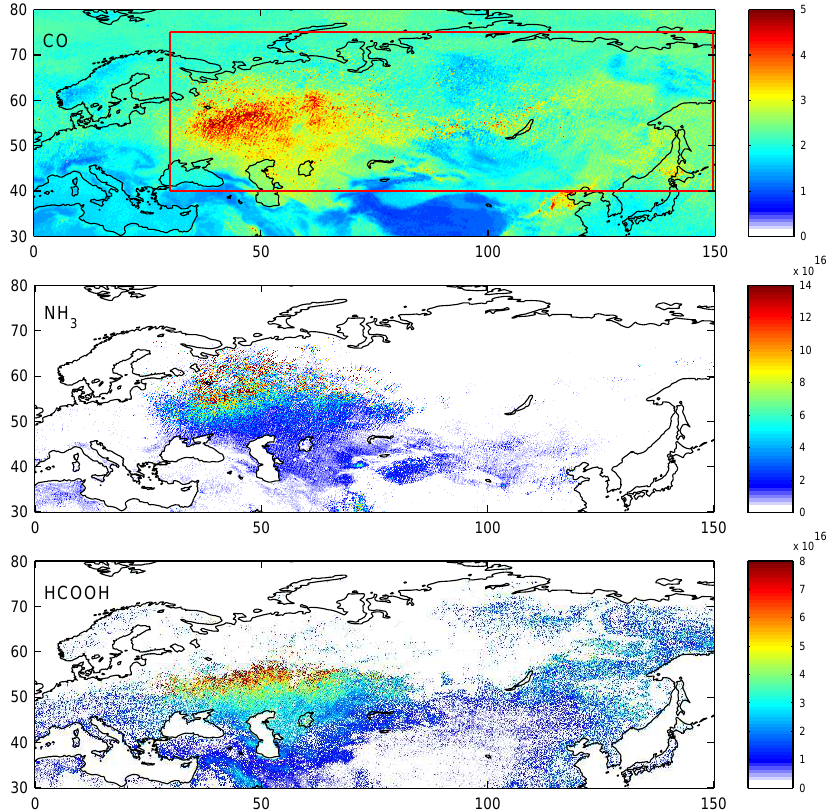
Fig. 1. IASI morning observations of the 2010 Russian wildfires plumes. The 3 panels show the mean CO, NH 3 and HCOOH total columns Fig.1. IASImorning observations ofthe2010 Russianwildfiresplumes. The3panelsshow themean CO , NH 3 and HCOOH totalcolumns in molec cm − 2 , in grid cells of 0.5 ◦ × 0.5 ◦ for one month, from July 27 to August 27 of 2010. inmoleccm − 2 , in grid cells of 0.5 ◦ × 0.5 ◦ for one month, from 27 July to 27 August agreement with recent studies of Yurganov et al. (2011), Witte et al. (2011)and Mielonen et al. (2012)which reported mean values between 2 and 4 10 18 molec cm − 2 in differ- ent areas around Moscow. The higher than average CO to- tal columns observed above Central Russia between January 180 and June 2010 (Fig. 2b) are due to the usual seasonality of that species, maybe intensified in springtime by the transport of fire plumes from outside the studied region (Parrington et al., 2012). Similarly, the progressive increase in NH 3 and HCOOH fromMarchtothestartofthefirescanbeexplained 185